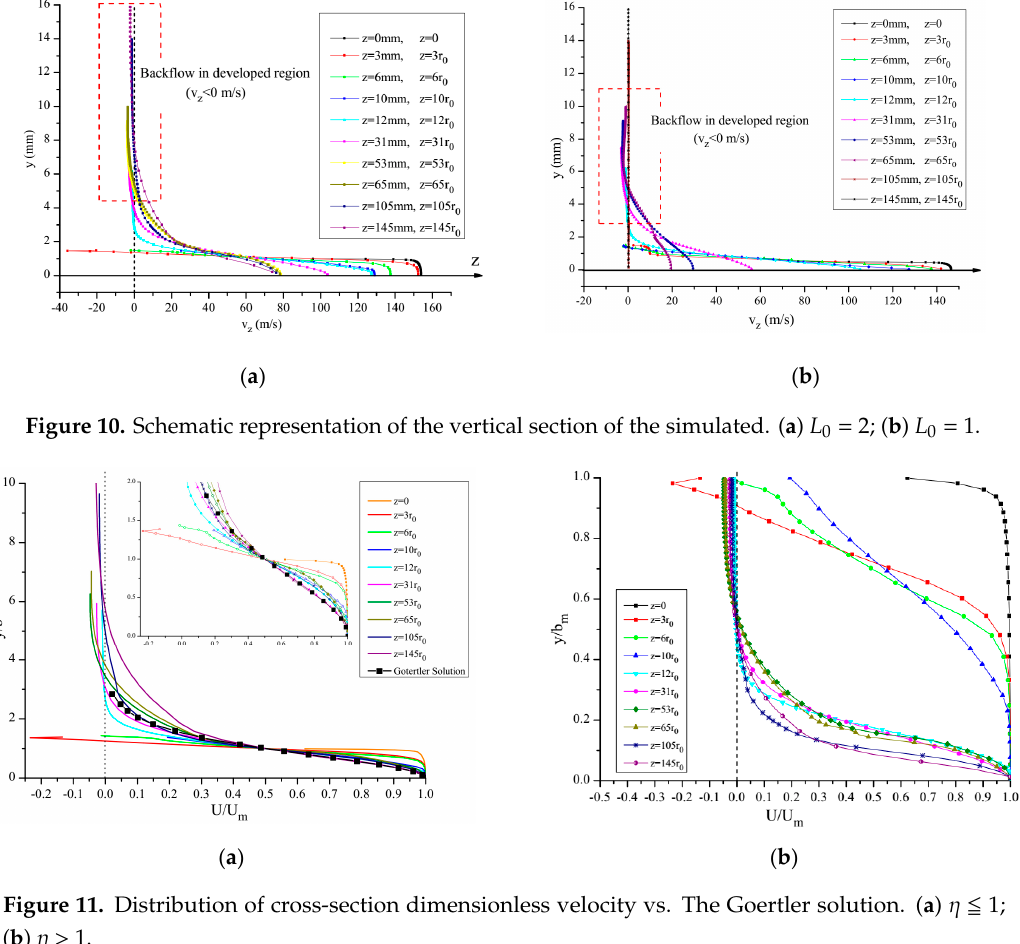
Figure 10. Schematic representation of the vertical section of the simulated . ( a ) L 0 = 2; ( b ) L 0 = 1.